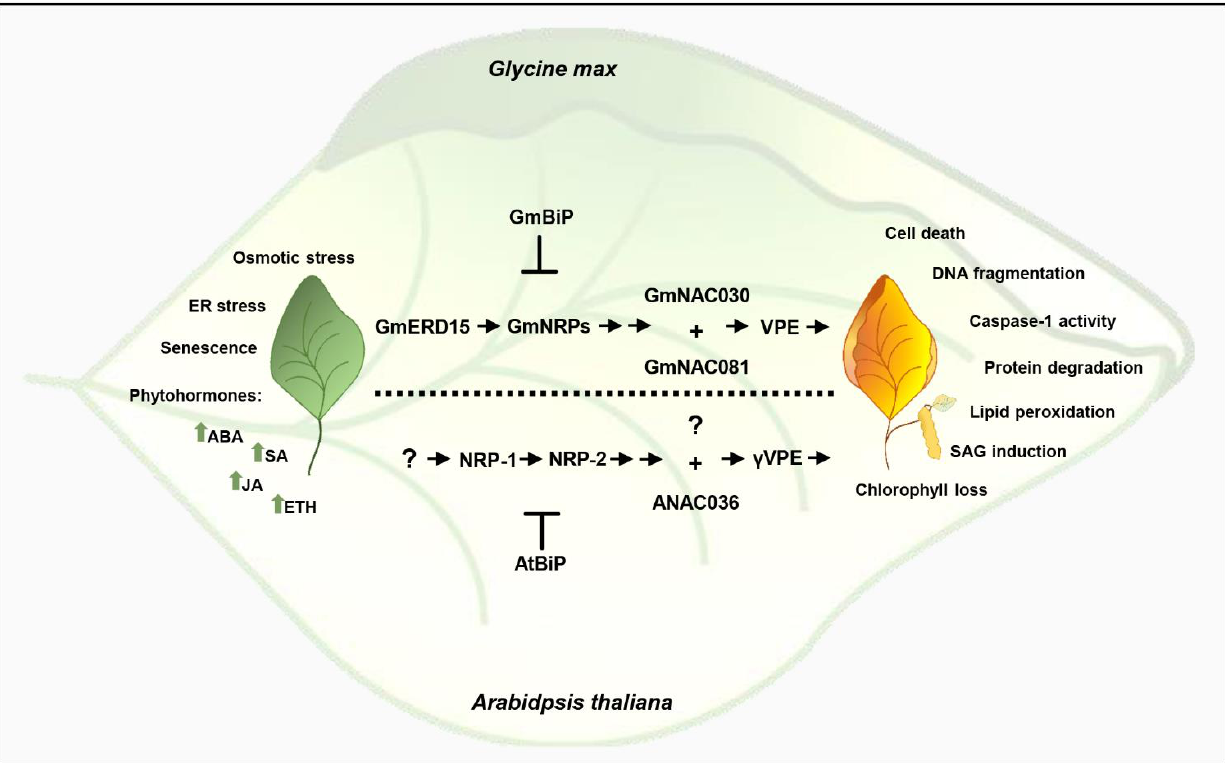
Figure 2. Integration of senescence signals and stress signals in the DCD/NRP-mediated cell death response. Leaf senescence, ER stress, and osmotic stress induce the expression of GmERD15, which upregulates GmNRPs to initiate a signaling cascade that culminates in the induction of GmNAC030 and GmNAC081 expression. The NAC transcription factors form a heterodimer to fully induce VPE promoter activation, leading to VPE expression and subsequent execution of a cell death program. The phytohormones positively regulate the signaling pathway, and the ER-resident molecular chaperone BiP acts as a negative regulator of cell death by modulating the expression and activity of the cell death pathway components. This DCD/NRP-mediated cell death signaling is conserved in other plant species, and the Arabidopsis orthologs are shown at the bottom of the figure.